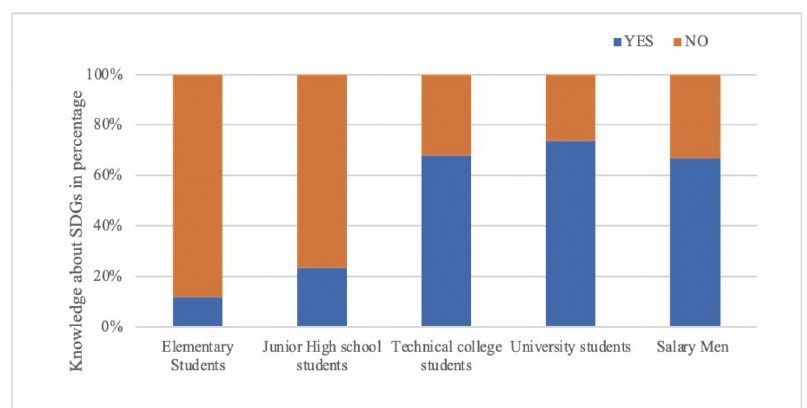
Figure 3. Participants knowledge on SDGs during survey